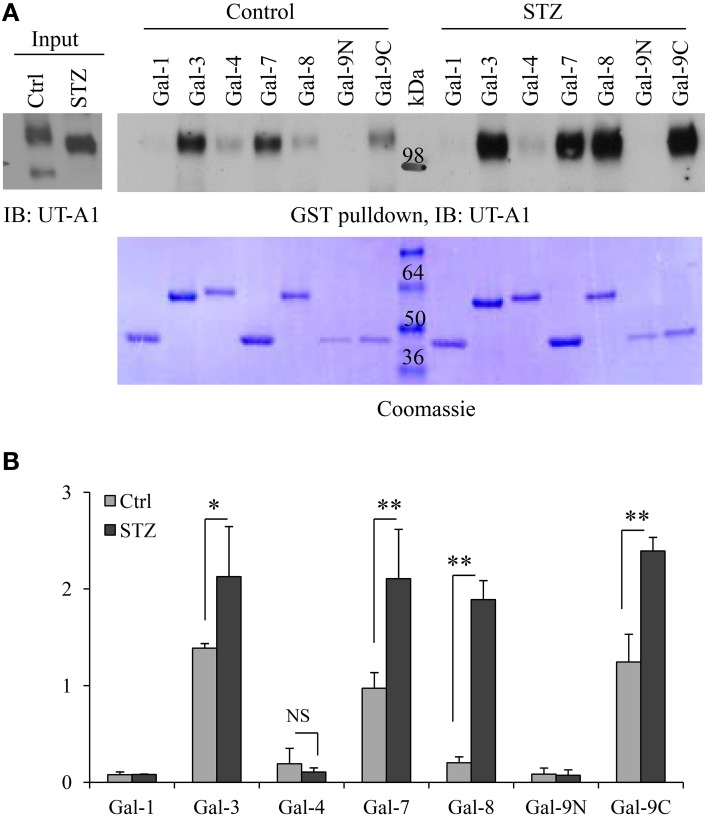
GST-galectin pulldown assays. (A) Equal amount of cell membrane fractions from rat IM tip were incubated with freshly prepared GST-galectin proteins for 1 h at 4°C. After washing with buffer A containing 14 mM β-mercaptoethanol and buffer containing 0.1 M sucrose, the galectin specific binding proteins were eluted by 0.1 M lactose (specific-binding) and subsequently analyzed by Western blot with UT-A1 antibody (Top). The same membrane was stained by Coomassie brilliant blue to verify GST fusion galectin proteins (Bottom). (B) Densitometry analysis of UT-A1 protein bands from three separate experiments (n = 3). Each GST-galectin precipitated UT-A1 was normalized with UT-A1 from input (means ± SD, *P < 0.05, **P < 0.01, NS, no significance).